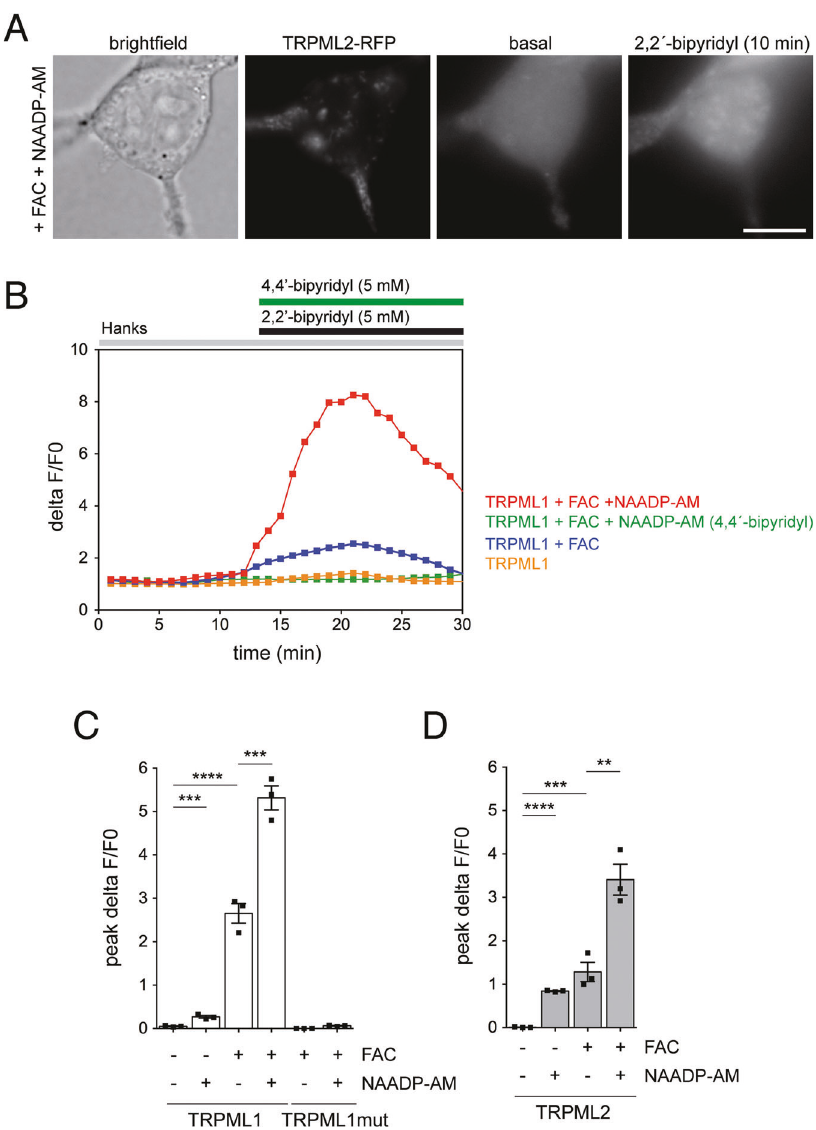
Fig. 3 TRPML1 and TRPML2 channel-expressing cells display a FAC-induced increase in free cytosolic Fe 2 + levels. A Representative example of dequenching of TRPML2-mRFP-expressing HEK293T cell upon incubation with FAC (50 μ M, 24 h) and 100 nM NAADP-AM for the last 12 h. Cells were pre-loaded with the iron-sensitive dye Phen Green SK, followed by addition of the membrane-permeable transition metal chelator 2,2´-bipyridyl which chelates free cellular iron and causes a concomitant increase in Phen Green SK fl uorescence. Scale bar, 10 μ m. B Example of 2,2´-bipyridyl-induced normalized changes in fl uorescence (deltaF/F0) in TRPML1-expressing cells (average of 30 – 40 cells per condition) in the absence or presence of FAC and NAADP-AM as indicated. Green trace shows the absence of fl uorescence dequenching upon addition of 4,4´-bipyridyl, an analog of 2,2-bipyridyl which cannot bind iron. C Quanti fi cation of the 2,2´-bipyridyl-induced normalized change of peak fl uorescence (peak deltaF/F0) in either wild-type or point-mutant TRPML1-expressing cells in the absence or presence of FAC and NAADP-AM as indicated. D Same as C , but in TRPML2-expressing cells. Bars represent mean ± s.e.m. (**** p < 0.001; *** p < 0.005; ** p < with no gender-dependent differences observed (not shown) [47, 48]. As compared to healthy controls, a signi fi cant increase in total iron was detected in the cortex of G2019S-LRRK2 PD patients, with a trend observed for substantia nigra and caudate (Fig. 1A). Determination of manganese or zinc levels from the same samples did not reveal differences between G2019S-LRRK2 PD patients and controls in any of the brain areas examined (Fig. 1B, D). However, a signi fi cant decrease in total copper content was observed in the caudate and cortex of G2019S-LRRK2 PD patients as compared to controls, with a trend observed for substantia nigra (Fig. 1C). These data indicate that identical to sporadic PD patients [49 – 52], G2019S-LRRK2 PD patients also display regional increases in iron